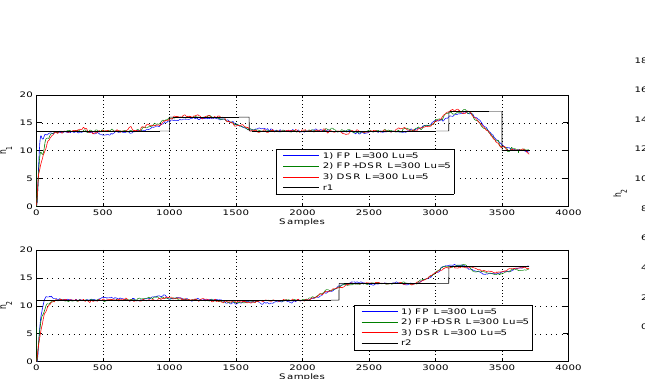
Figure 8: Quadruple tank process. Level in tank one. Illustrating the reference and the outputs from the process controlled by two single loop PI controllers, and the proposed LQ optimal controller with integral action. The LQ con- troller where constructed by using the DSR method for system identification. The DSR model was used to identify a Kalman filter for the system. The states where estimated with this Kalman filter and the determinis- tic part of the model were used to design the